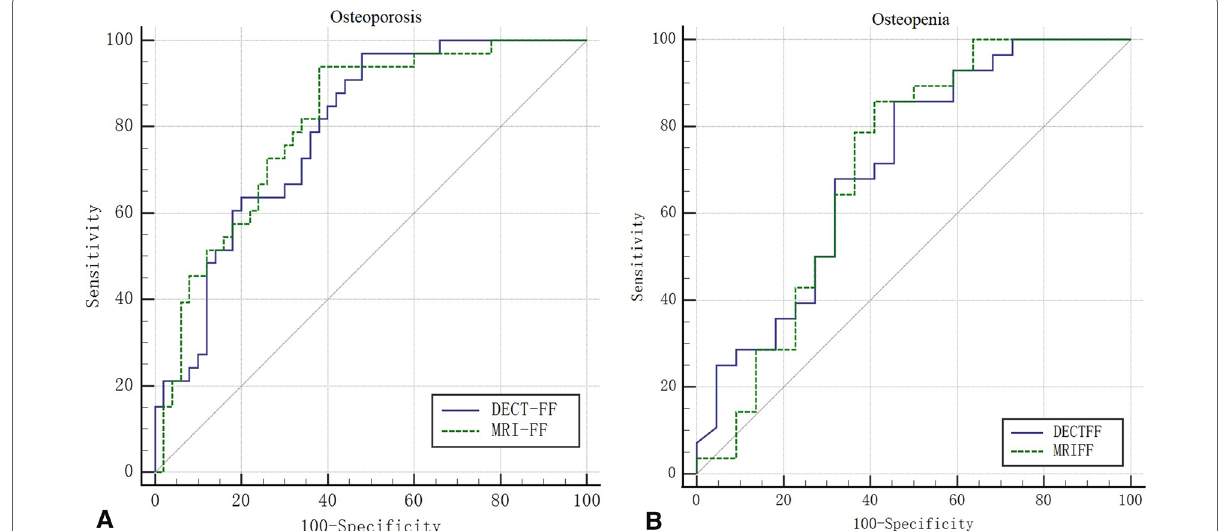
Fig. 6 ROC curve of DECT-FF and MRI-FF in OP and Osteopenia diagnosis. A The AUC of DECT-FF and MRI-FF in the diagnosis of OP were 0.791 and 0.807, respectively; B The AUC of DECT-FF and MRI-FF in the diagnosis of Osteopenia were 0.710 and 0.708, respectively. DECT: Dual-energy computed tomography, MRI: magnetic resonance imaging, FF: fat fraction